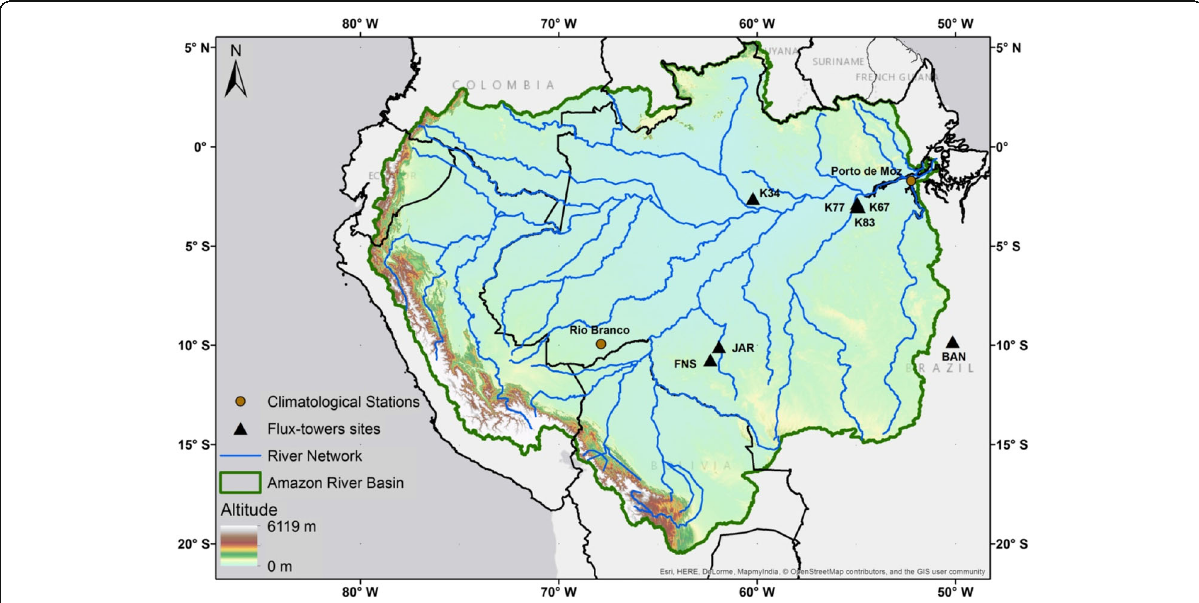
Fig. 1 Location of the Amazon River Basin. The altitude is taken from the USGS Digital Elevation Model (USGS, 2004). The location of the flux tower sites (black triangles) and two meteorological stations (brown dots) are